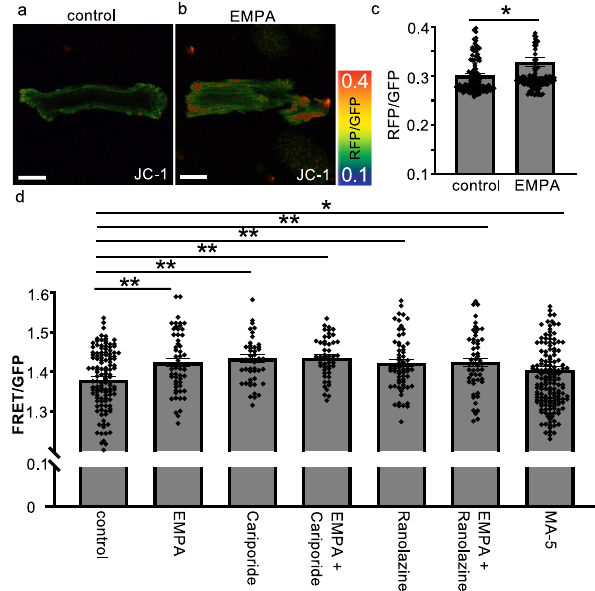
Fig. 6 Empagli fl ozin promotes mitochondrial activity via the NHE1 and Nav1.5 pathways. a , b Measurement of mitochondrial membrane potential using JC-1. Representative cellular images from each condition (EMPA empagli fl ozin). Warmer colors indicate higher mitochondrial membrane potential. Scale bar: 25 μ m. c Graph of the mitochondrial membrane potential of mature cardiomyocytes with control ( n = 120), empagli fl ozin 10 nM ( n = 134). * p = 0.021. d Graph of the FRET/GFP ratio in mature cardiomyocytes isolated from 8-week-old mitoATP-Tg mice 1 h after addition of control ( n = 67), 300 nM empagli fl ozin ( n = 54), 10 μ M cariporide ( n = 49), cariporide and empagli fl ozin ( n = 49), 30 μ